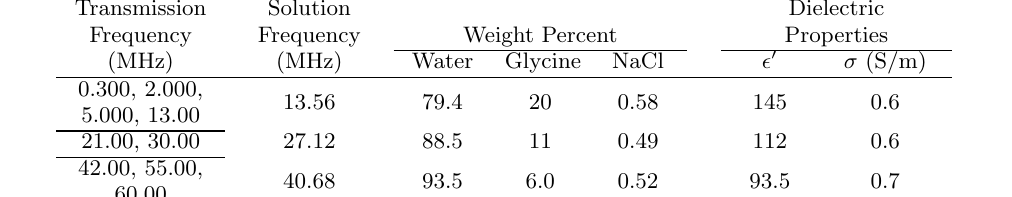
Table 1: Formulations for muscle simulating phantoms matched to transmission frequencies.